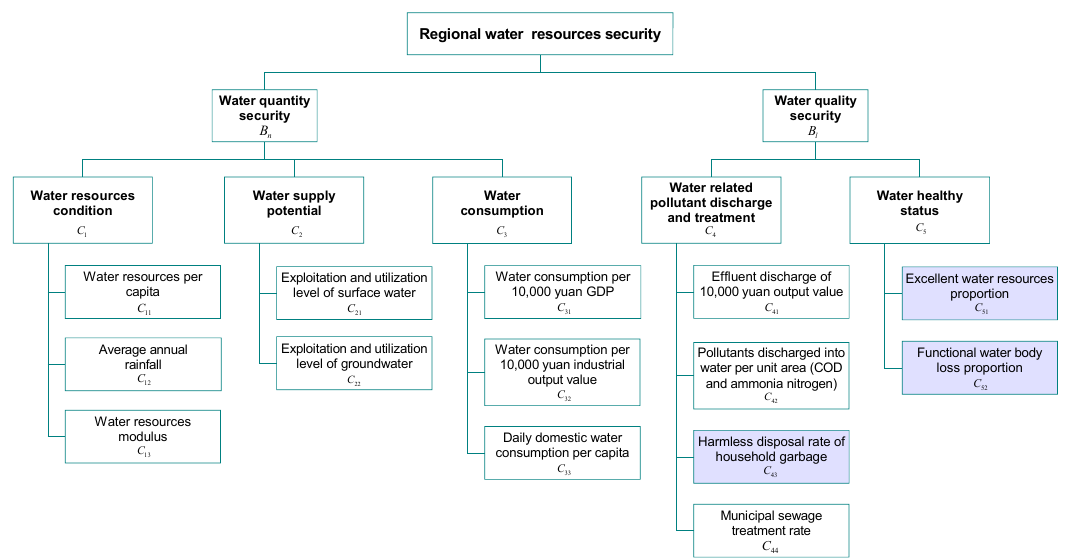
Figure 1. Regional water security evaluation indicator